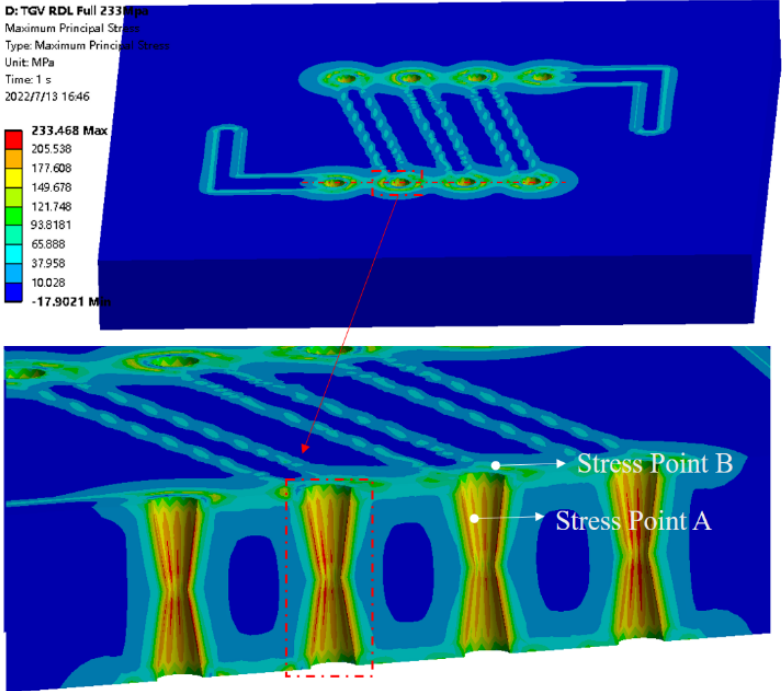
Figure 8. Stress distribution of the Cu ‐ filled via on TC.